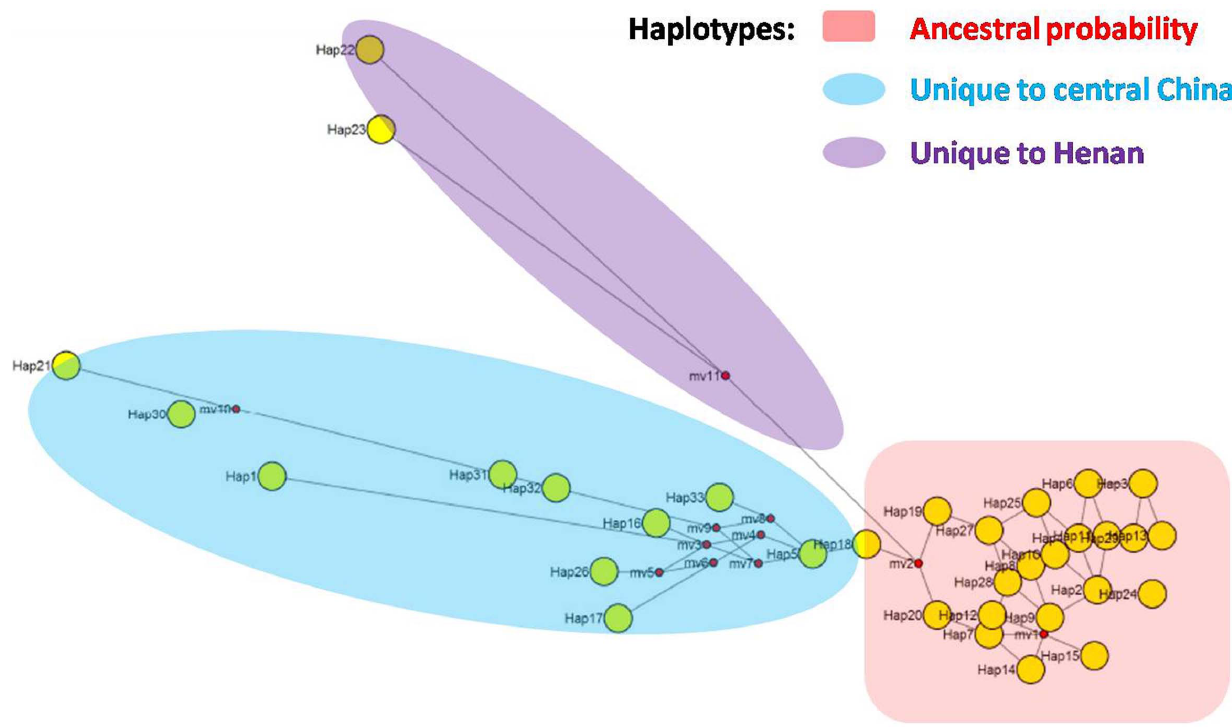
Figure 4. Haplotype networks of 288 isolates at ITS1 locus. The sampled haplotypes are indicated by circles; the geographical regions from which the sample was collected and the size of the circles are proportional to the observed haplotype frequency. The super linkage populations depict the haplotype with the highest ancestral probability (light red), and each branch indicates mutational separation (light blue and purple). Internal nodes (yellow) are representative of ancestral haplotypes. Media Vector (mv, red) indicate the vector between two ancestral haplotypes.